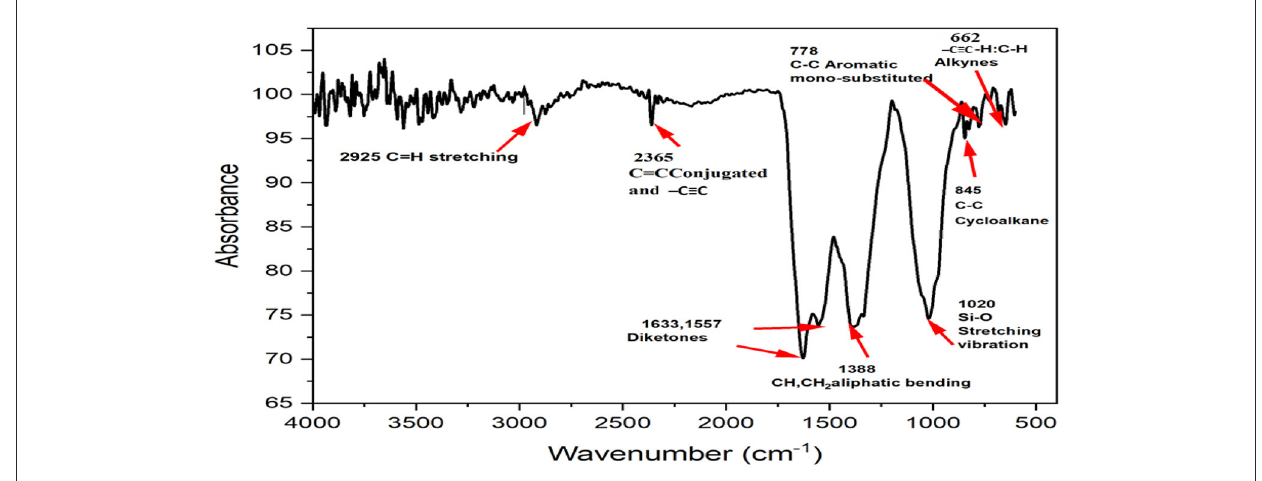
FIGURE7 Fourier transform infrared (FTIR) analysis of the synthesized Ag